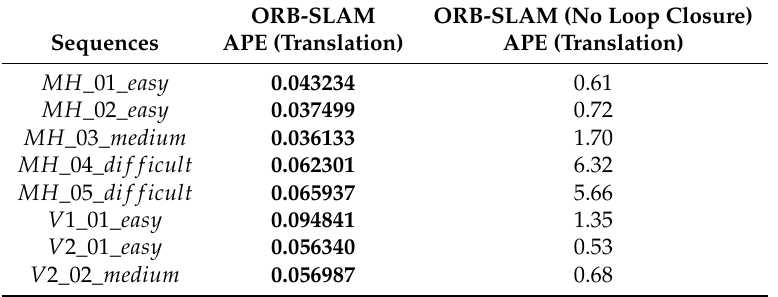
Table 3. Evaluation results of the evo tools on ORB-SALM algorithms. The table shows the error in the translation part of the APE in meter. Bold numbers indicate that the estimated trajectory is closer to the true